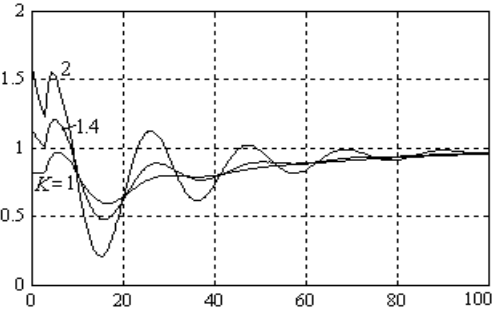
Figure 26. Control responses u ( t ) to a unit step reference for K = 1; 1.4; 2.